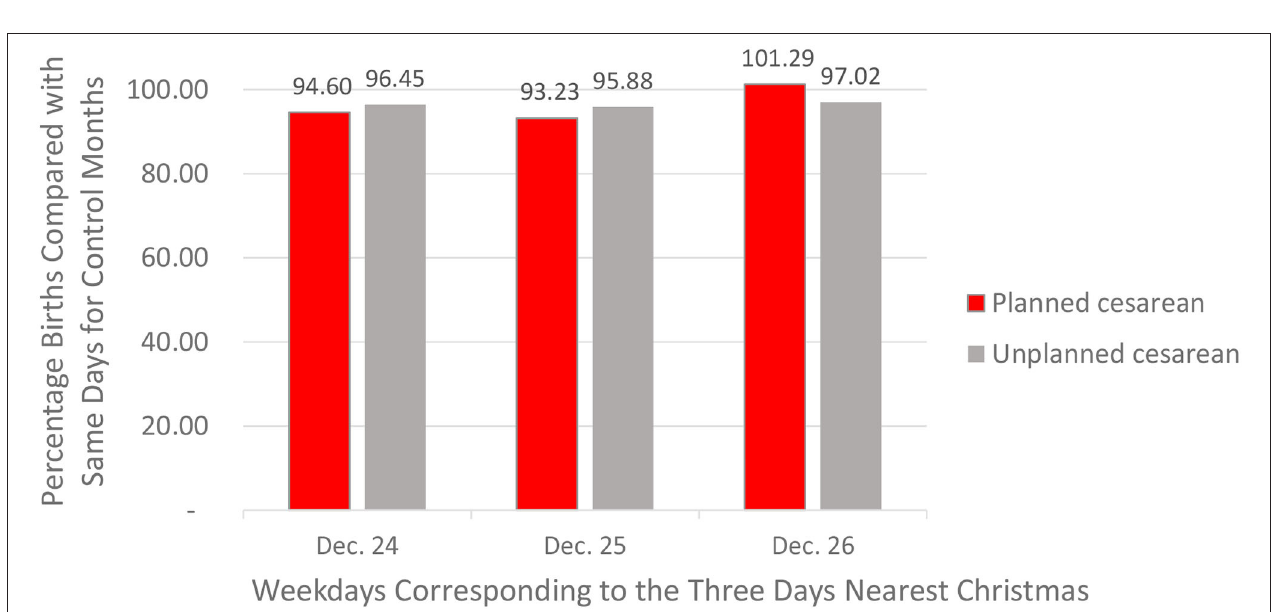
FIGURE 11 | December birth deficits (compared with matched control days) for planned vs. unplanned births by cesarean section on the days of the week corresponding to December 24, 25, and 26 (CDC Data).